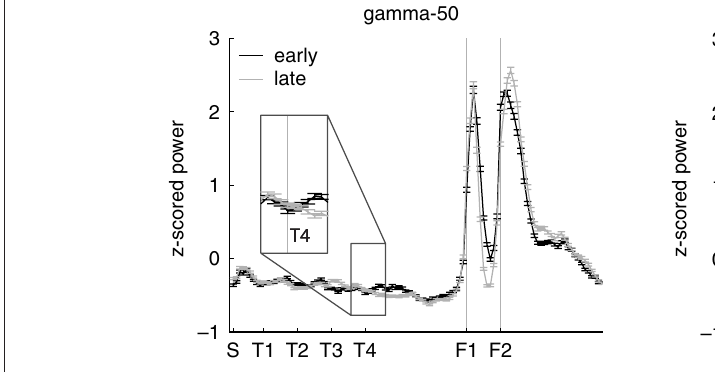
Insets show a close up at T4. As shown in Figure 5 , overall power levels for both gamma-50 and gamma-80 changed between early and late laps; this analysis reveals the spatial distribution of that power normalized for absolute